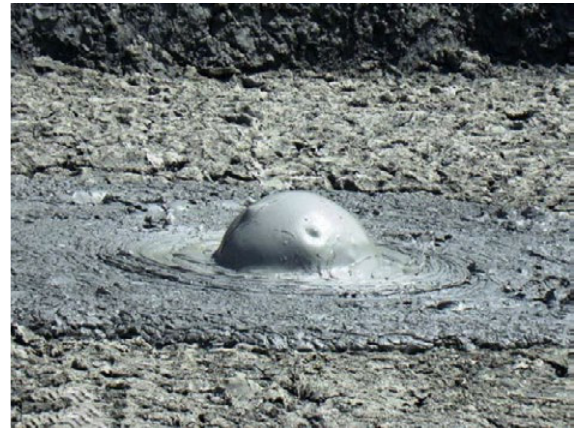
Fig. 4. Mud Fig. 4: Mud volcano